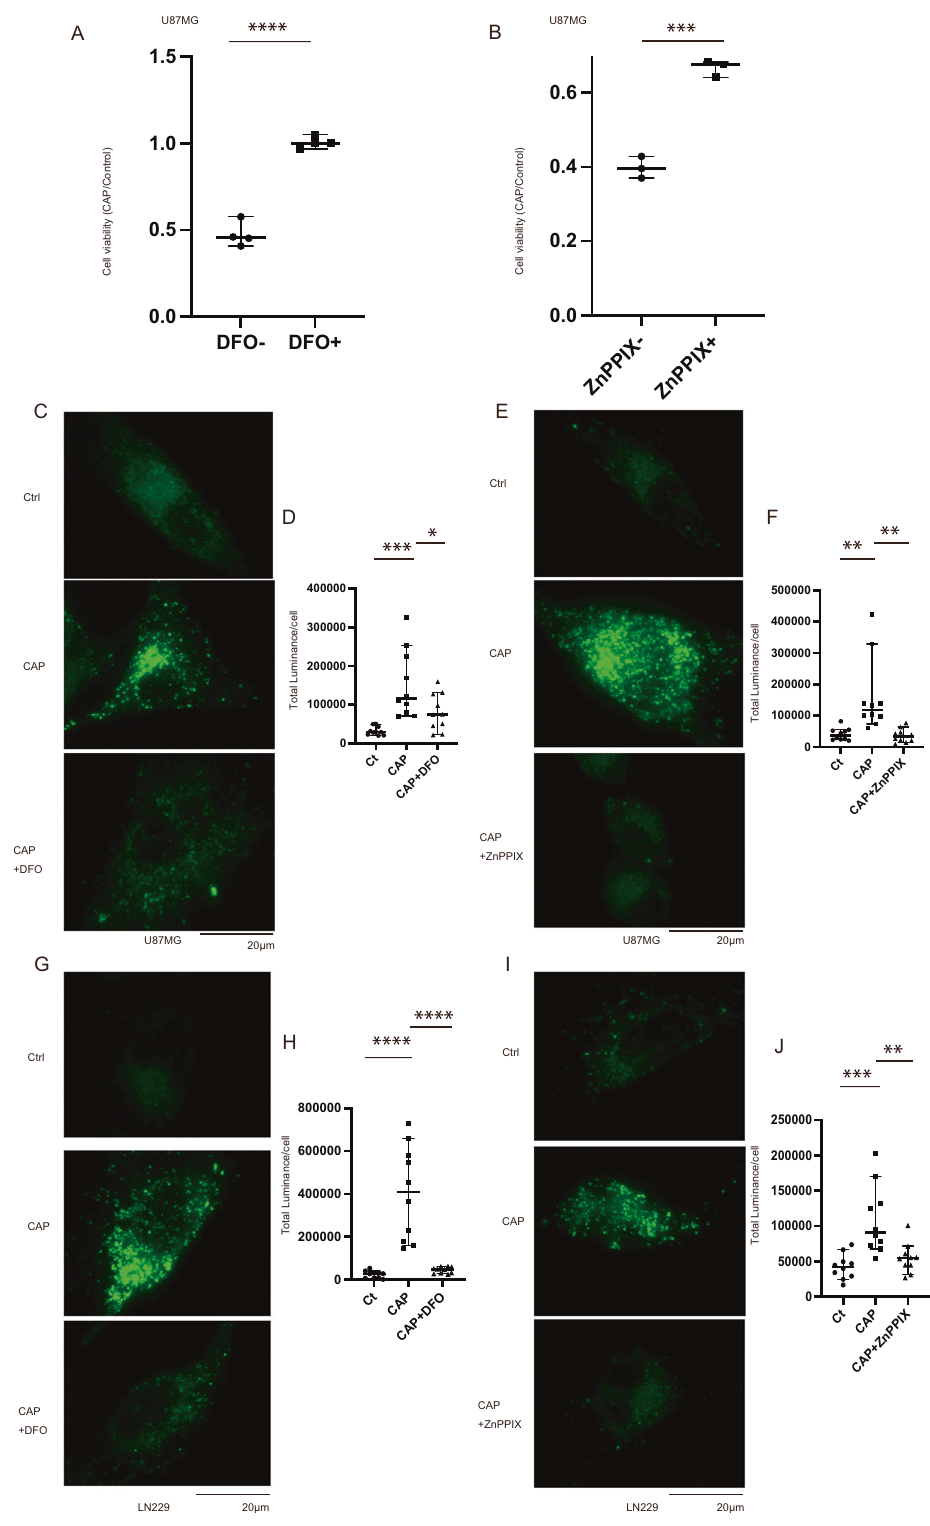
tricarboxylic acid cycle to deal with glucose starvation [40]. Nonetheless, there are no reports on the relationship between glucose starvation and COX expression. This study elucidated that glucose starvation elevated COX expression and mitochondrial